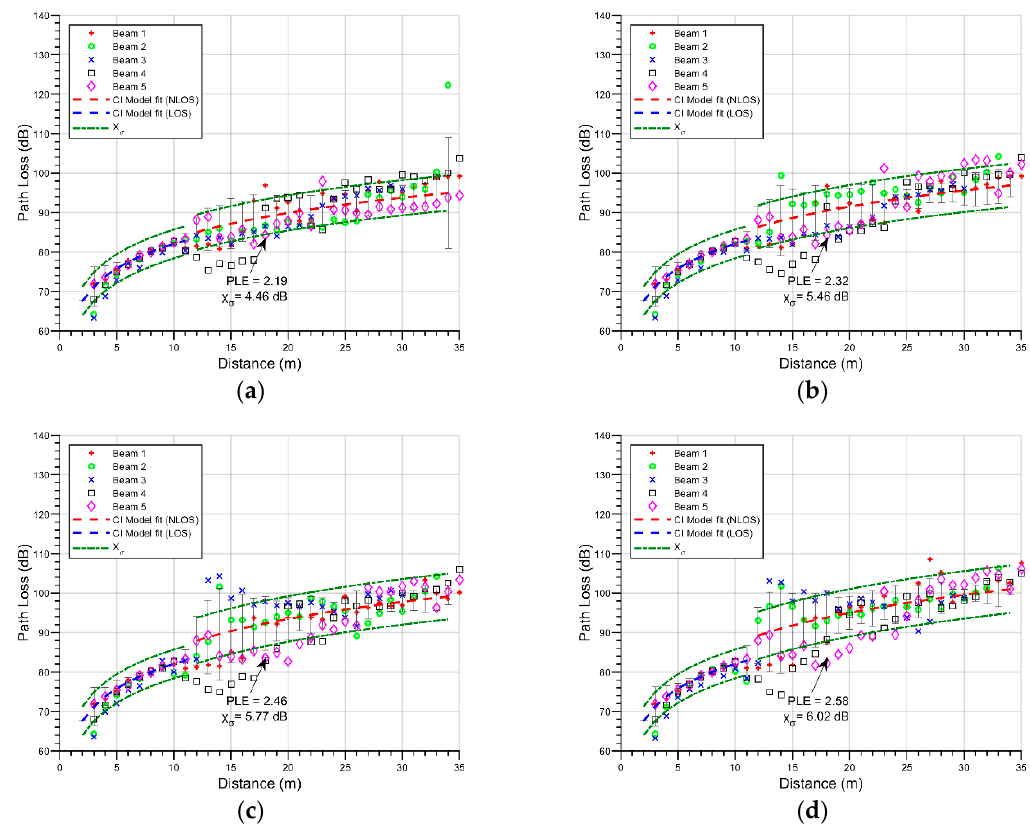
Figure 5. Path loss values for all beams and CI model fit: ( a ) 25% vegetation density scenario; ( b ) 50% vegetation density scenario; ( c ) 75% vegetation density scenario; ( d ) 100% vegetation density scenario.